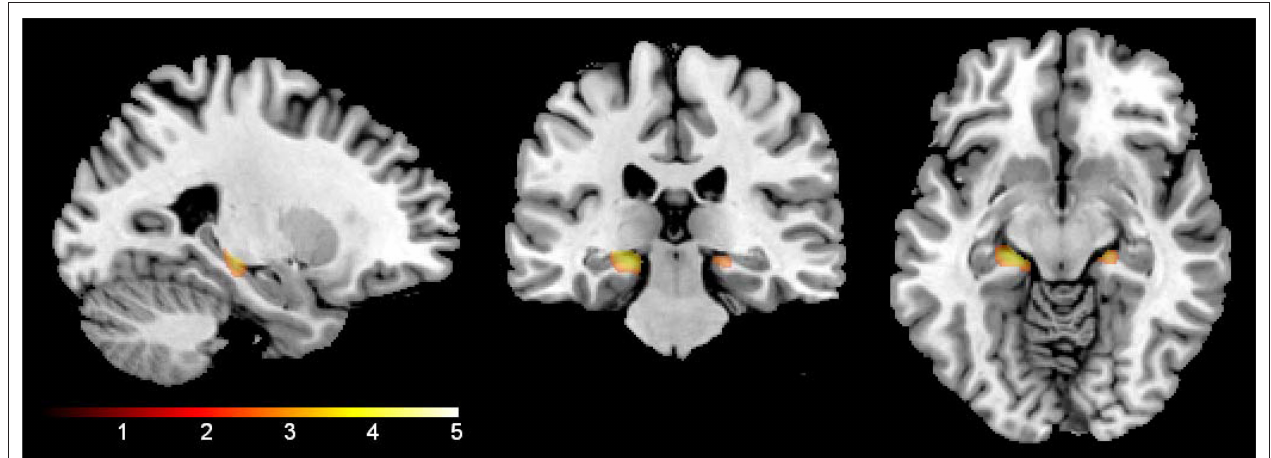
FIguRe 1 | Age by group interaction. NSAID users showed an attenuated age slope compared to non-user controls in bilateral hippocampi (shown below) and right parahippocampal gyrus (not pictured). The results are confined to the study’s a priori regions of interest (hippocampi and parahippocampal gyri). The color bar represents the height of the t -statistic.